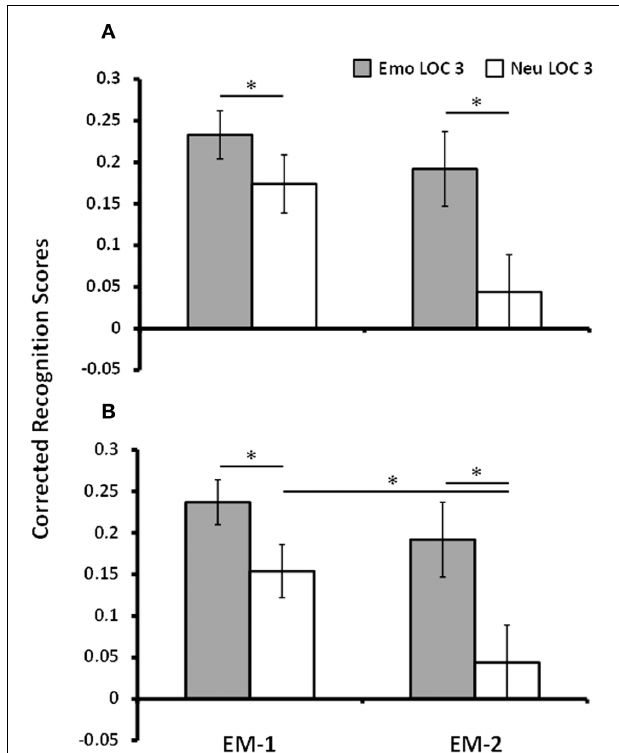
FIGURE 2 | Increased memory for emotional pictures. Figure shows corrected recognition scores for Emo and Neu LOC 3 items for EM-1 (left) and EM-2 (right). Memory performance was greater for Emo items than for Neu items in EM-1 and EM-2 (A) , which was also identified when tested with the subset of participants that had both EM-1 and EM-2 data (B) . There was a significant decrease in memory performance for neutral items from EM-1 to EM-2. Emo, Emotional; Neu, Neutral; LOC, Level of Confidence; EM-1, Episodic Memory task 1; EM-2, Episodic Memory task 2. ∗ indicates p -value < 0 . 05 ,